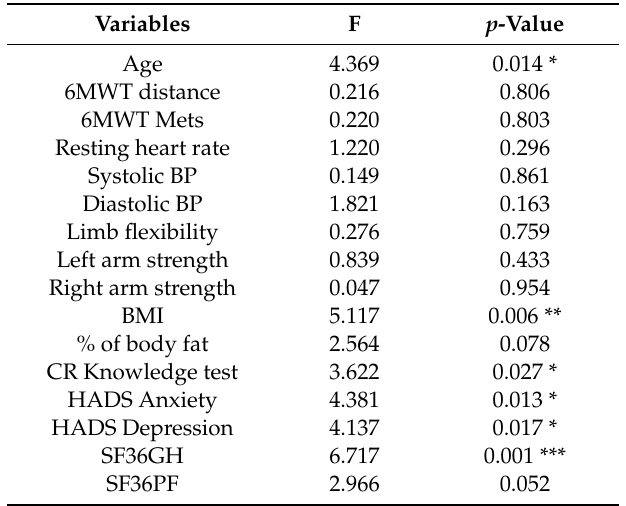
Table 2. One-way ANOVA factors contributing to the status